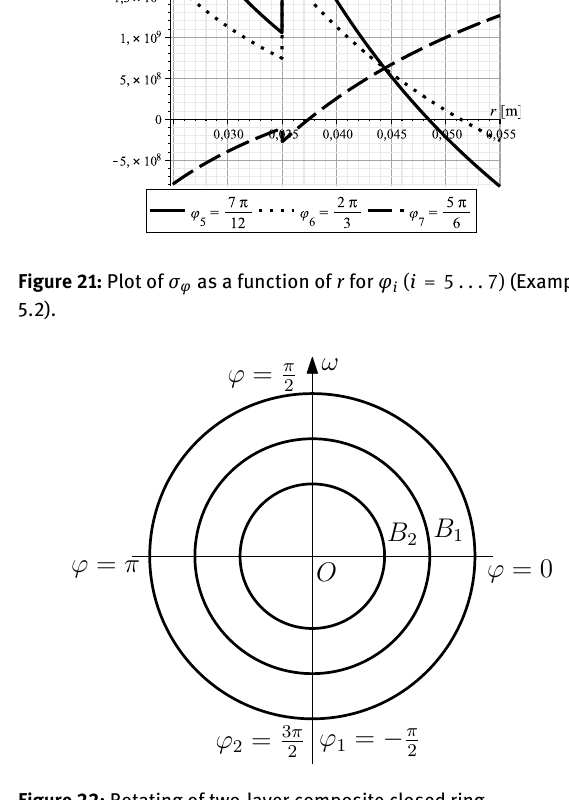
Figure 22: Rotating of two-layer composite closed